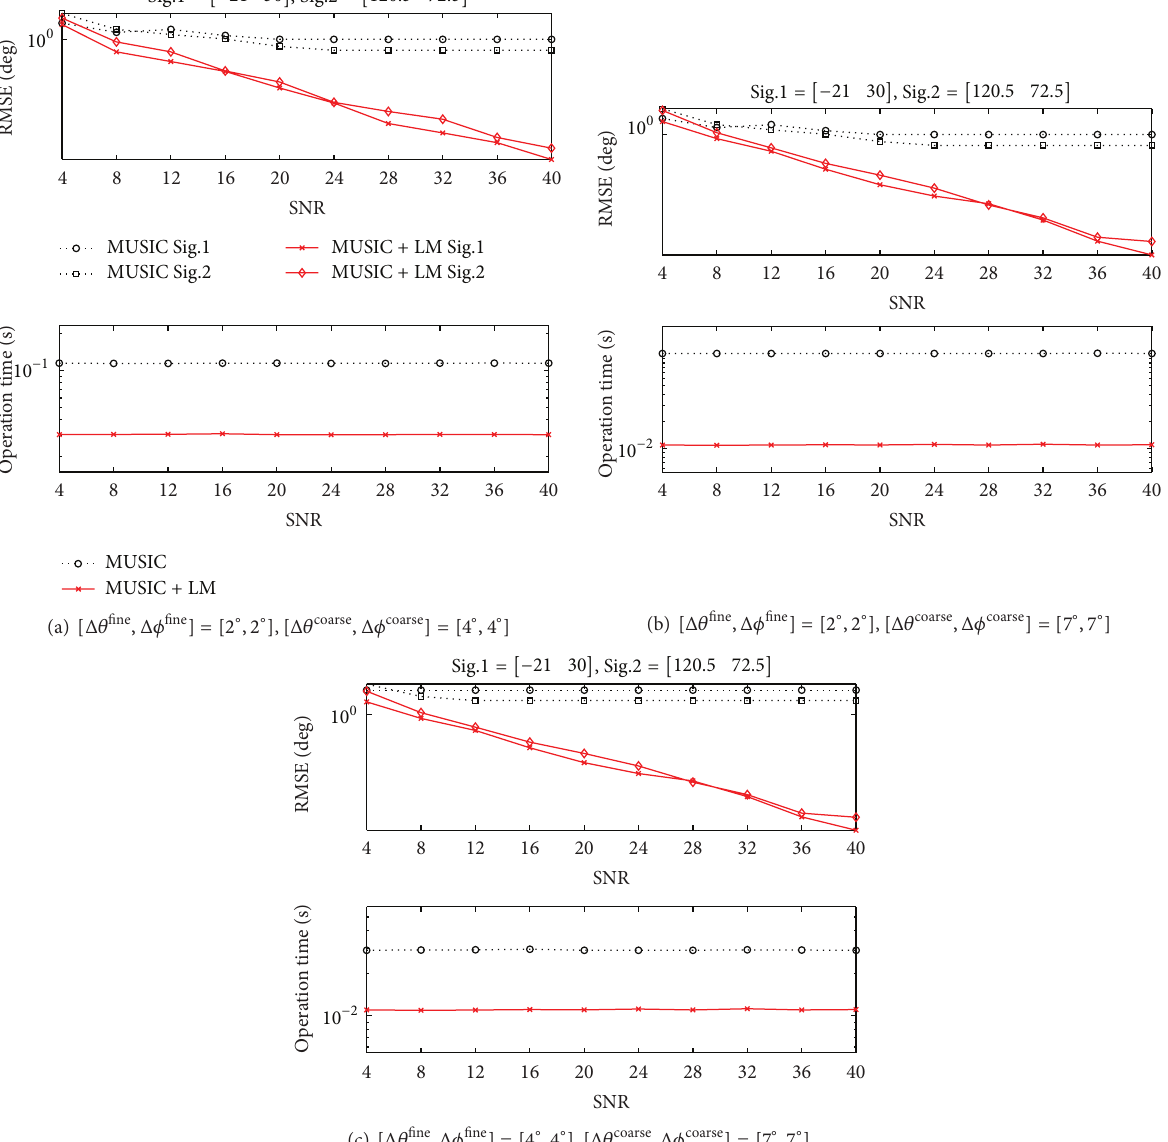
Figure 3: Comparison of the standard MUSIC algorithm with fine exhaustive grid search and the MUSIC algorithm with coarse exhaustive grid search followed by LM optimization ( 𝑟 = 0.679𝜆 , five antennas, [𝜃 ( true )